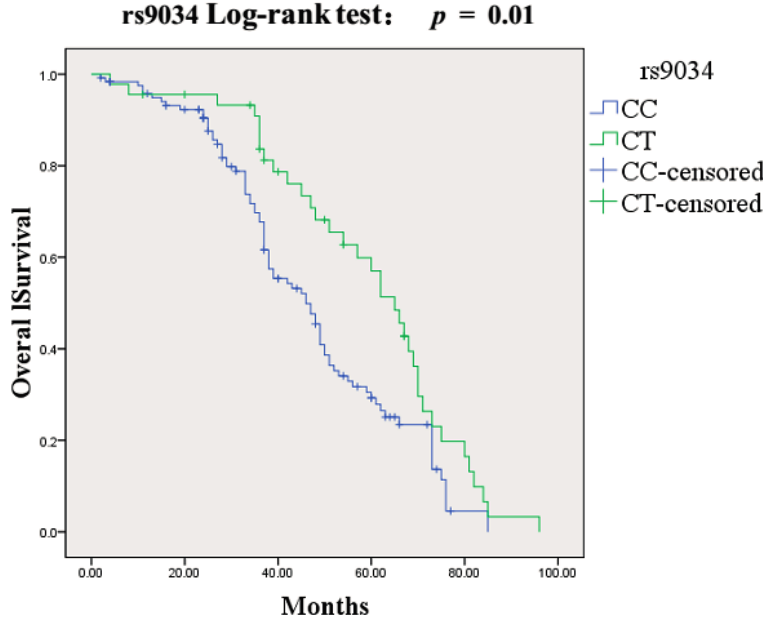
Figure 1. Kaplan-Meier survival curves free of cardiac death for 175 DCM patients based on rs9034. Table 4. Cox regression analysis of cardiac death in patients with DCM.